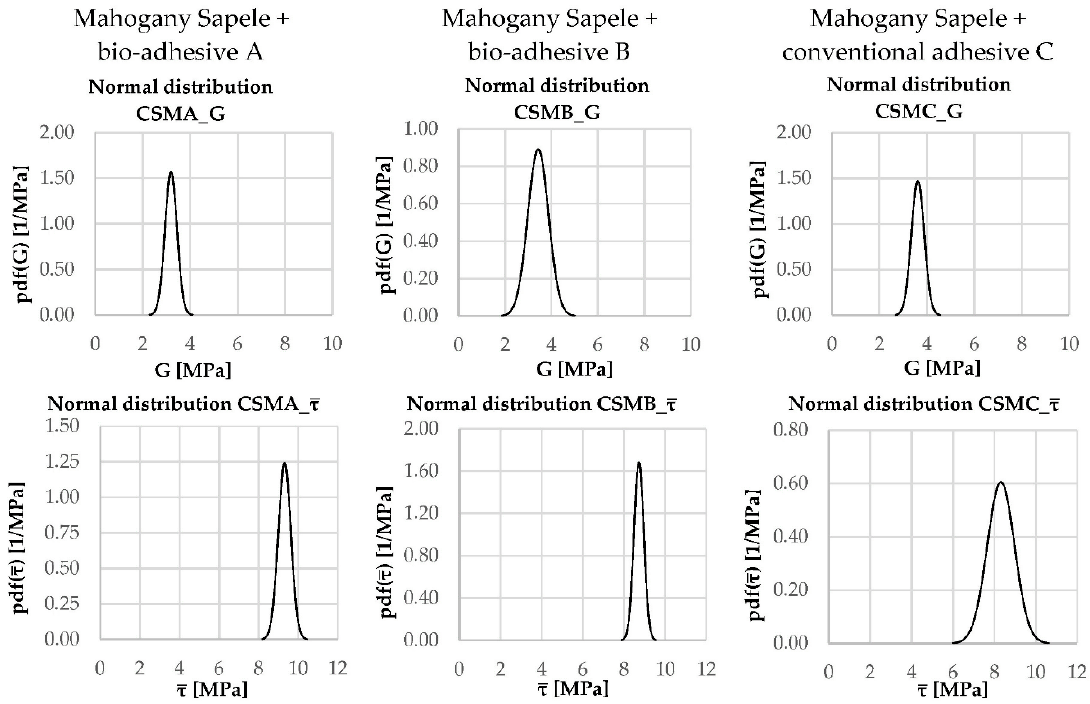
Figure A6. Statistical analysis for shear properties by compression loading on Mahogany Sapele specimens.